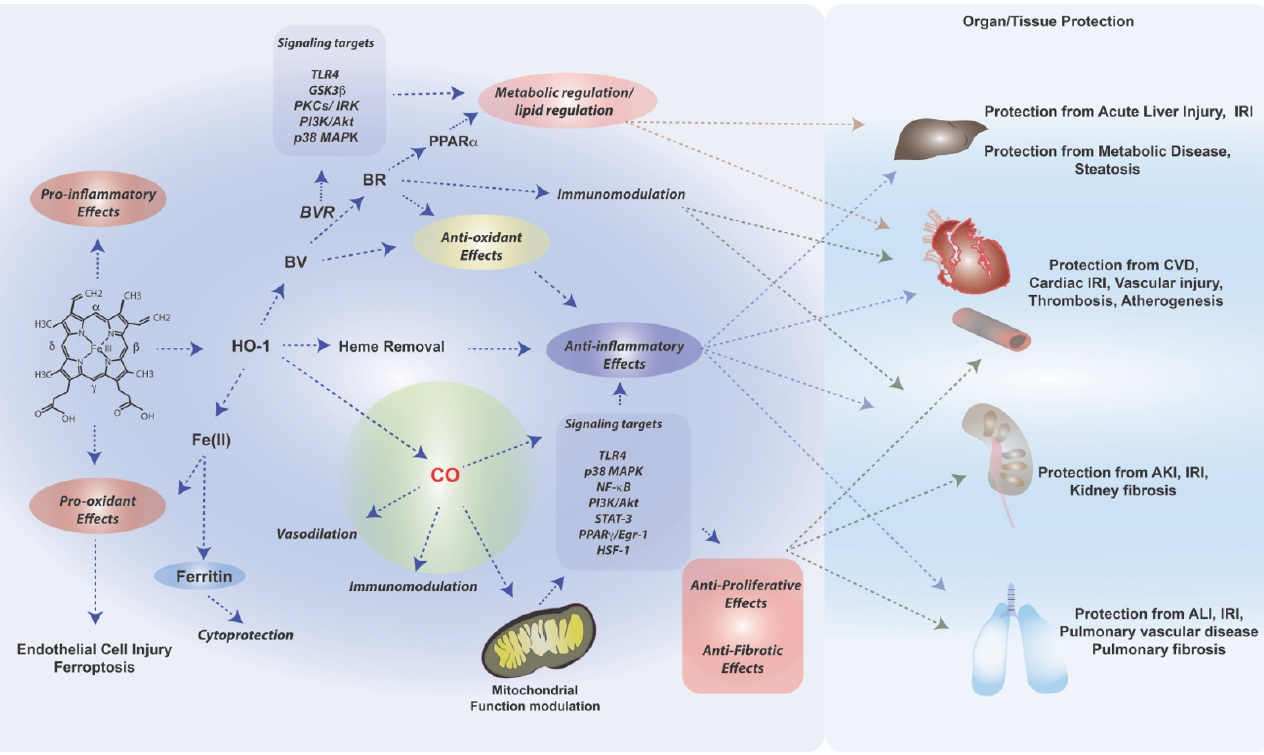
Figure 3. Role of HO-1/CO system in lung, vascular and kidney diseases. HO serves primarily a detoxification role in the removal of heme, which in free form can propagate inflammatory injury. Displacement of heme in exchange for labile iron may have toxic sequelae such as promotion of membrane lipid peroxidation and ferroptotic cell death. Labile iron triggers ferritin synthesis, which can contribute to vascular protection in CVD. Experimental models have suggested that BV/BR gen- eration may contribute to protection in vascular injury, IRI, AKI, and ALI. BV and BR are known PPAR α . BVR, which converts BV to BR, can modulate signaling pathways via intrinsic kinase activ-